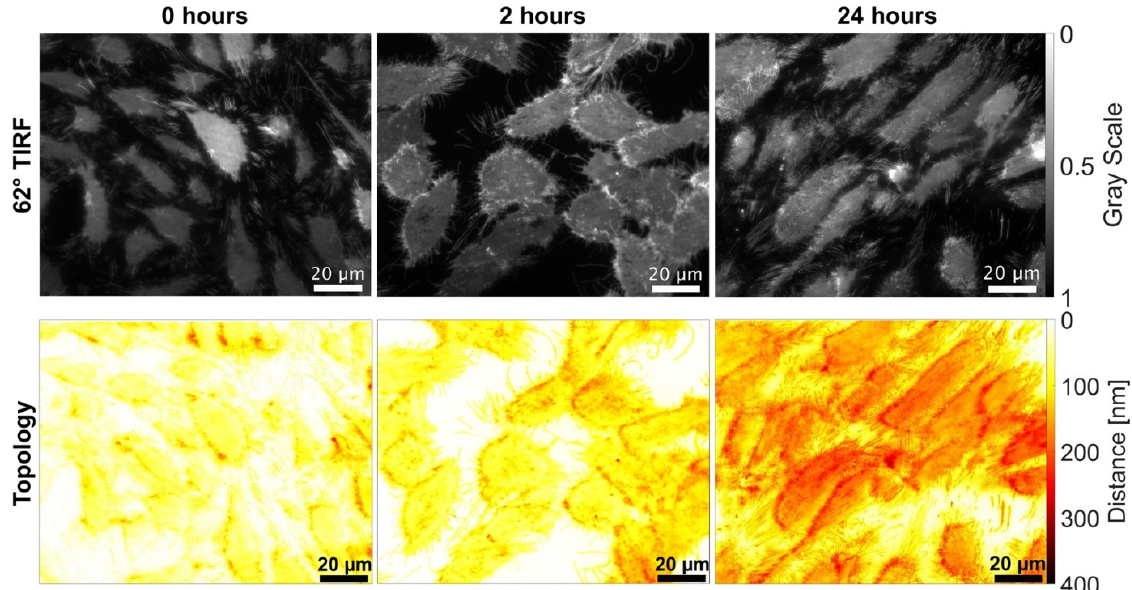
Figure 2. Fluorescence images at Θ = 66 ◦ excitation (upper part) and cell-substrate topology (lower part) for 0 h, 2 h, and 24 h incubation with doxorubicin (2 µ M) displayed in a color code. CHO-pAcGFP1-Mem cells of subcultures 56–64 after 72 h (left, middle) or 96 h (right) growth in culture medium.